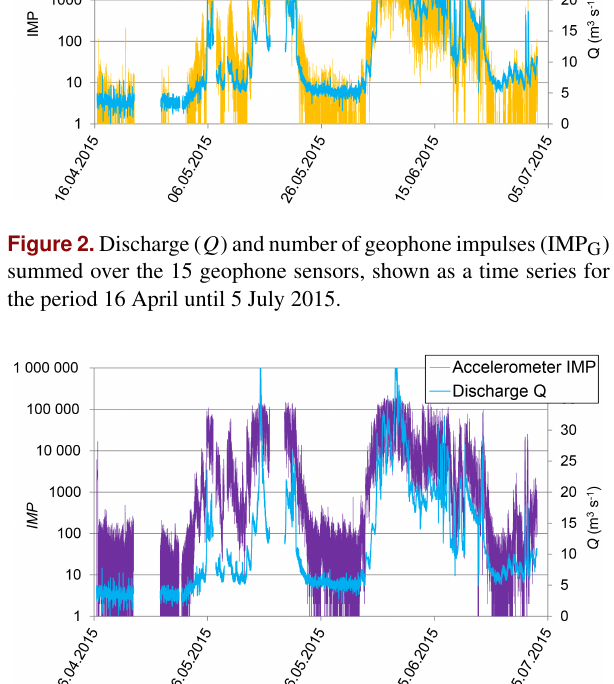
number) of impulses later in the season, from July until Oc- tober 2015, when discharge was mostly lower than 5 m 3 s − 1 .